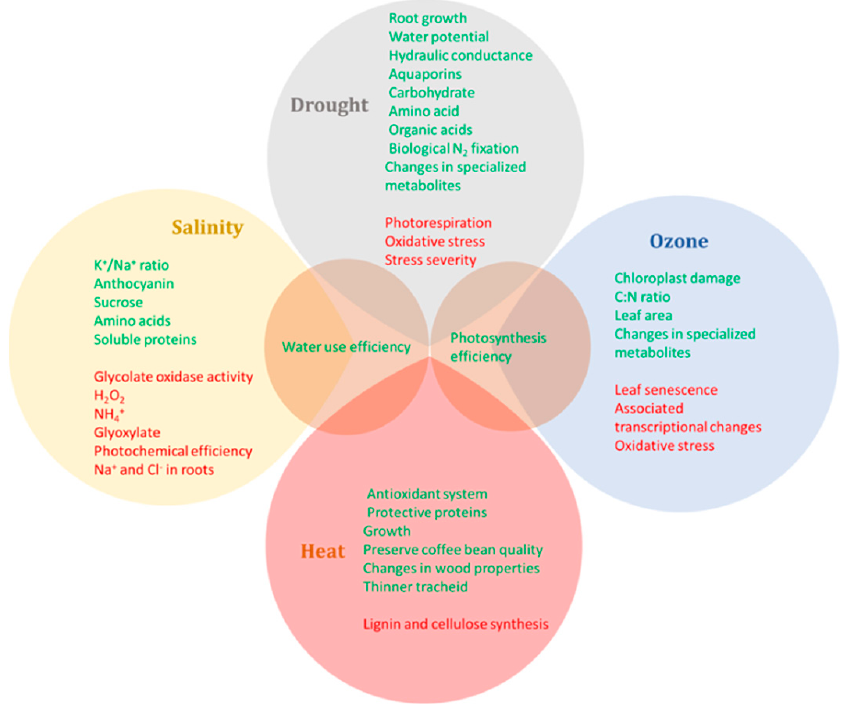
Figure 1. Venn diagram of the main effects caused by elevated CO 2 in combination with abiotic stresses (heat, drought, salinity and ozone) in woody plants. Green effects are increased or stimulated, and red effects are decreased or inhibited.